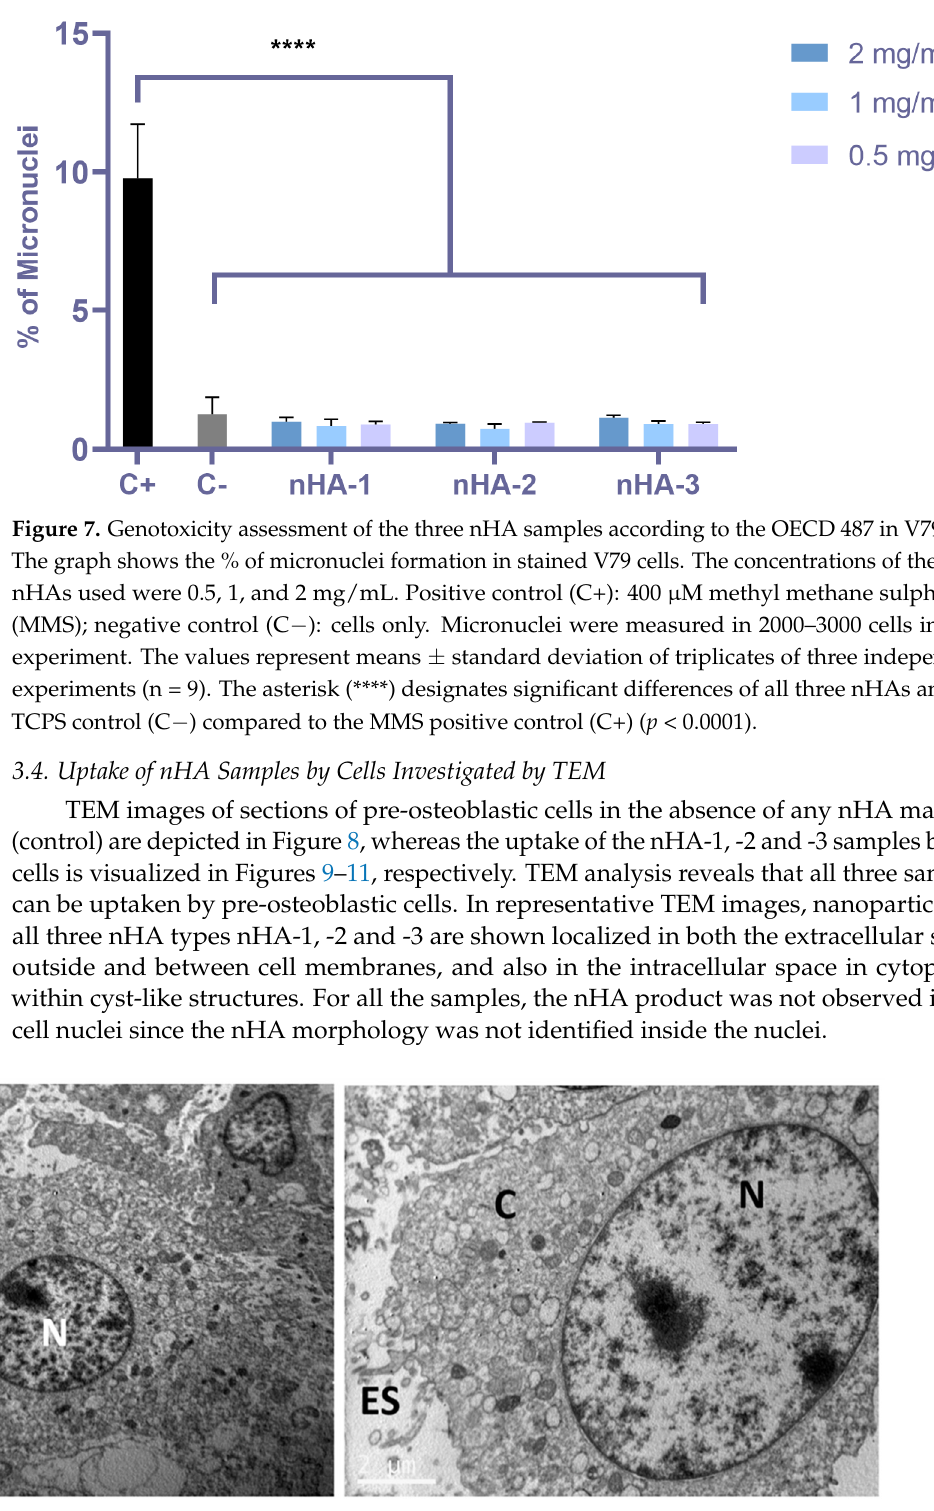
Figure 9. Representative TEM images showing nHA-1 uptaken by pre-osteoblastic cells. Nanoparticles of nHA-1 are shown localized and presented in both the extracellular and the intracellular space in cyst-like structures. The scale bar represents 1 μ m. The letter C designates the cytoplasm and ES the extracellular space. The arrows depict the nanopartic- ulated sample nHA-1.